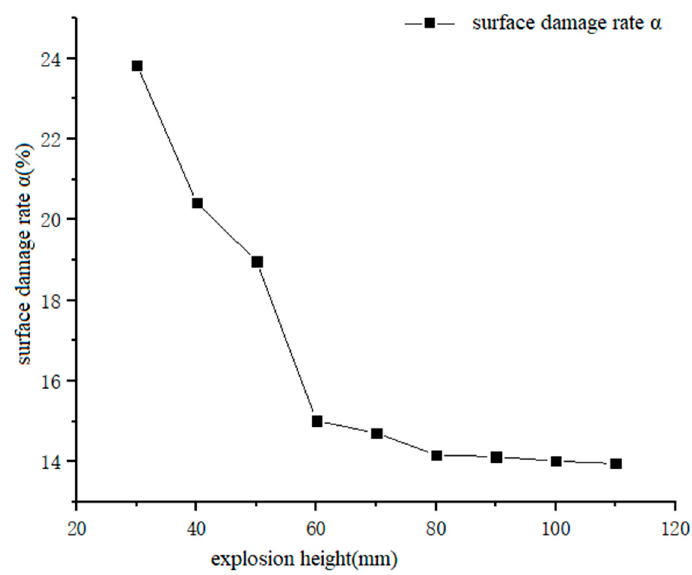
Figure 12. Curves of α data that correspond to different explosion heights.